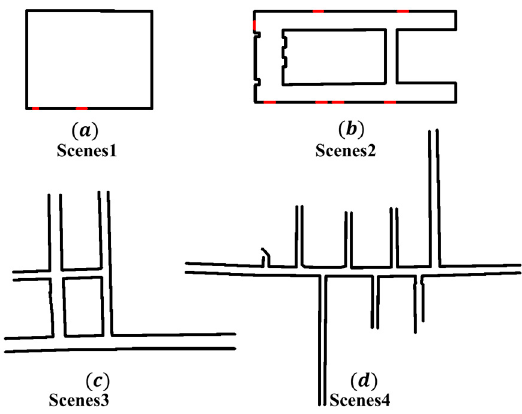
Figure 10. Schematic diagram of four scenes of structured corridors and mine roadways.